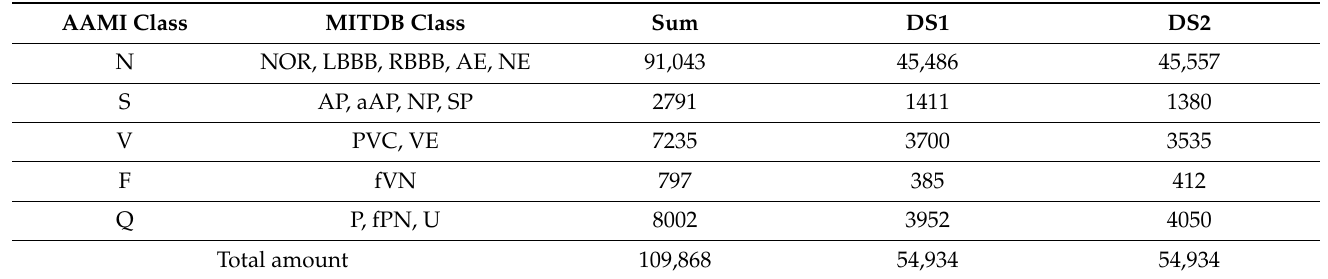
Table 2. Evaluation scheme of the MITDB heartbeat